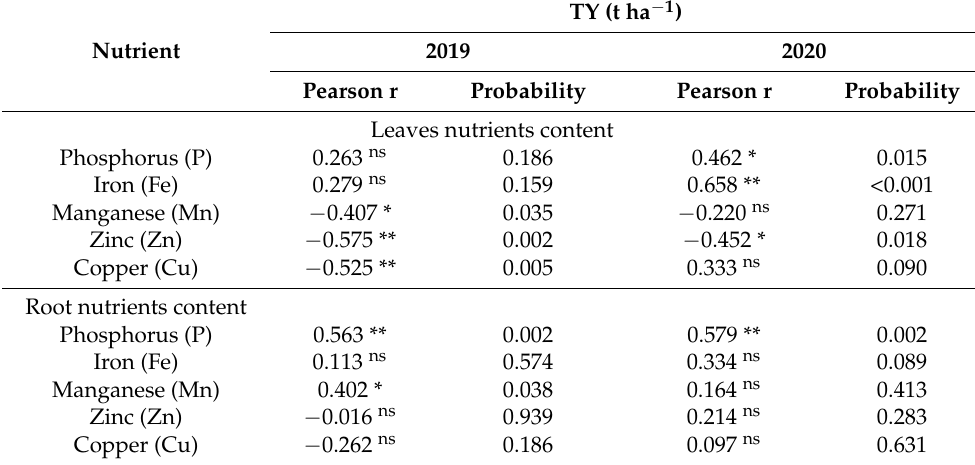
Table 6. Pearson’s correlation coefficients between total yield (TY) and each of leaf and root nutrient content of stressed sweet potato plants exogenously sprayed with different levels of zinc oxide nanoparticles and ascorbic acid in both the 2019 and 2020 seasons.